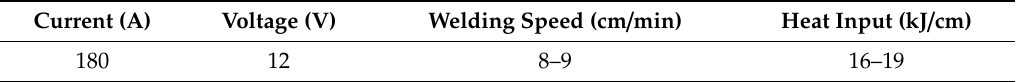
Table 2. Welding parameters of